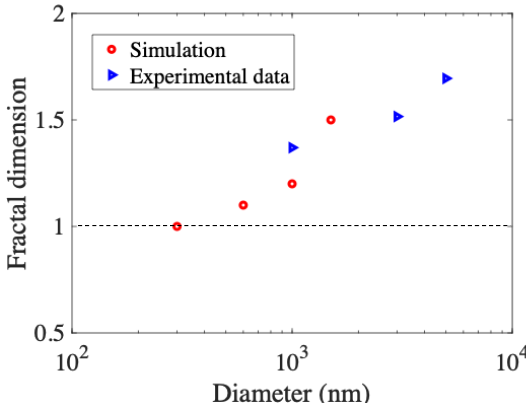
Figure 4. Size effect on the fractal dimension of dislocation microstructure. Experimental data are obtained from